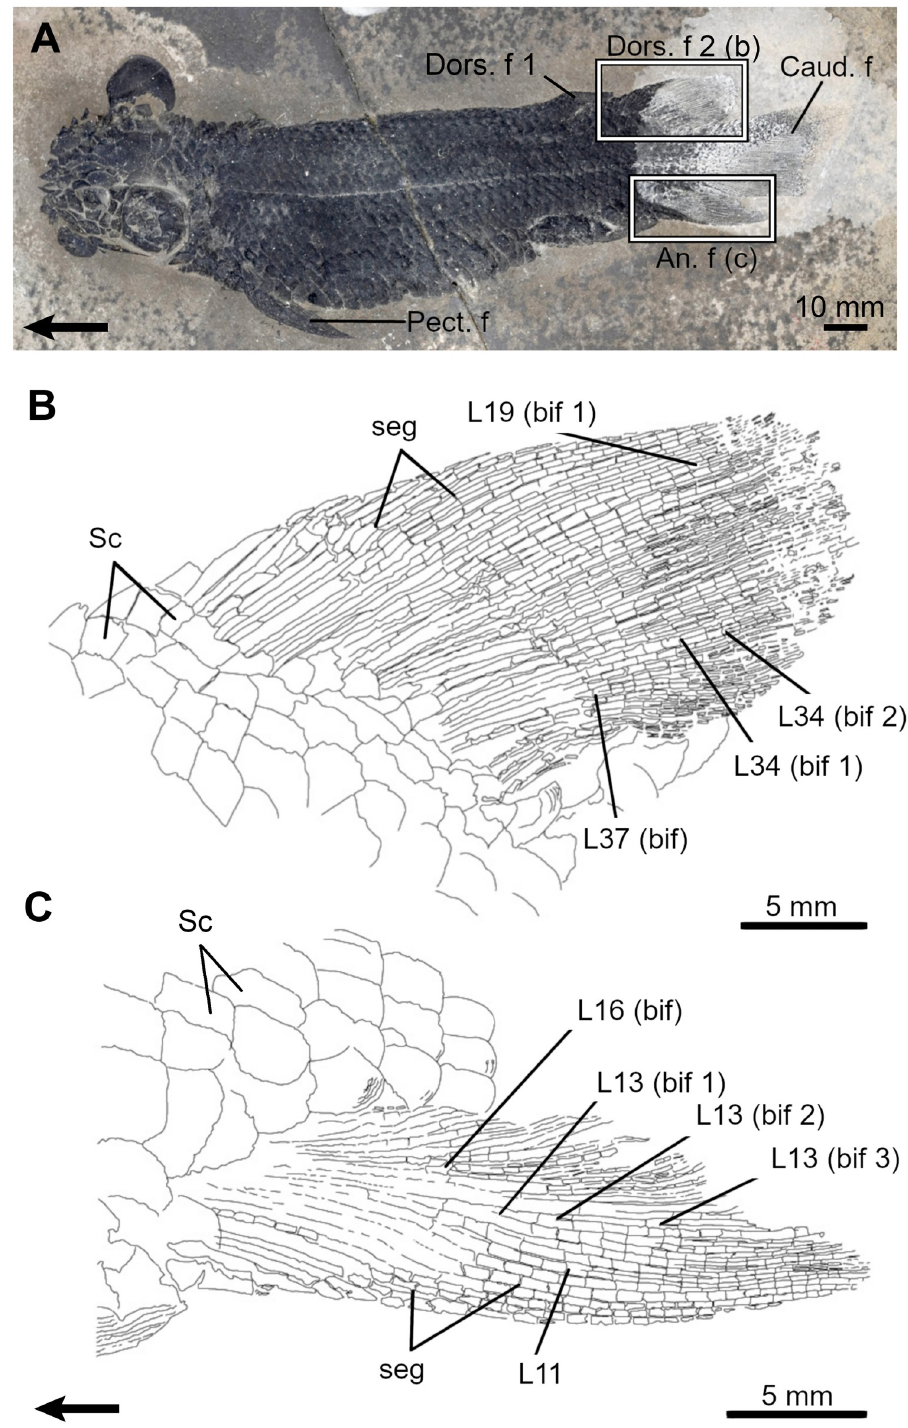
Fig 9. The Devonian dipnoan Dipterus valenciennesi . A, Fossil specimen of (BMNH P.22187) and drawings of its second dorsal (B) and anal (C) fins. Note the development of scales (Sc) covering the proximal portion of the lepidotrichia. Arrows point anteriorly. An. f, anal fin; bif, bifurcation; Caud. f, caudal fin; Dors. f, dorsal fin; L, lepidotrichia; Pect. f, pectoral fin; seg, segmentation.